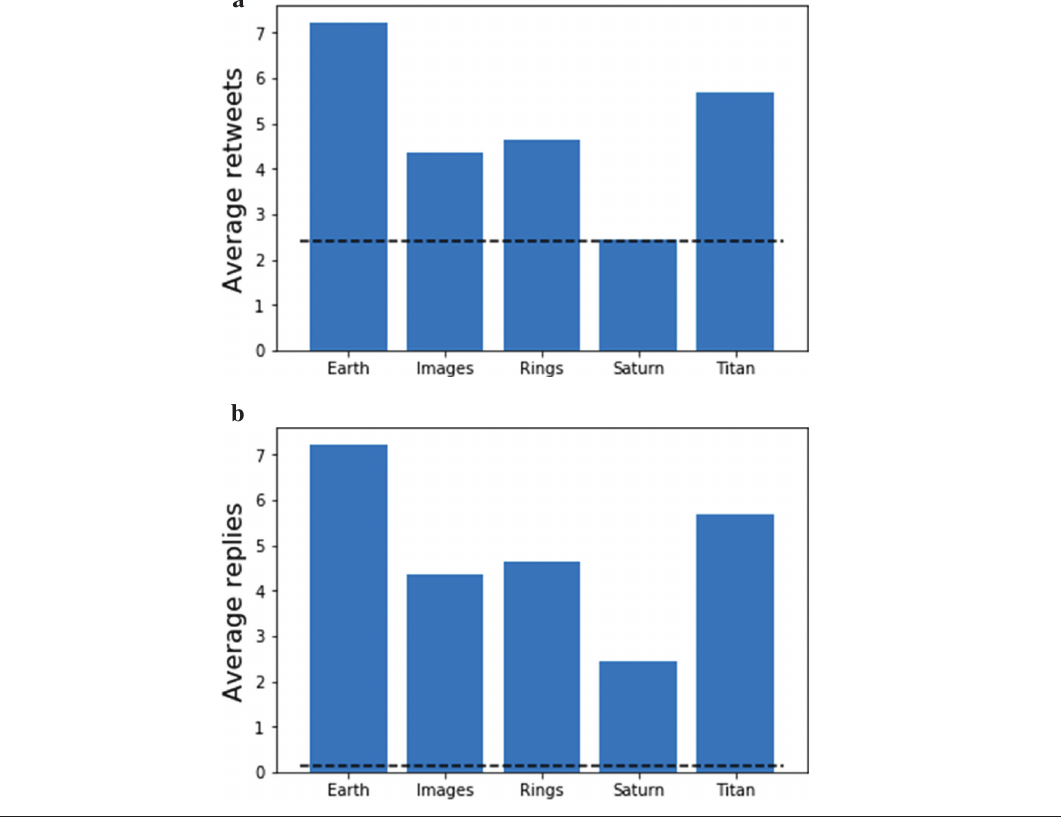
Figure 10. (a) The average number of retweets for tweets containing ‘Saturn Cassini’, containing certain keywords; (b) similar, but for replies. Dashed lines indicate the average activity for all ‘Saturn Cassini’ tweets (Source: Authors,